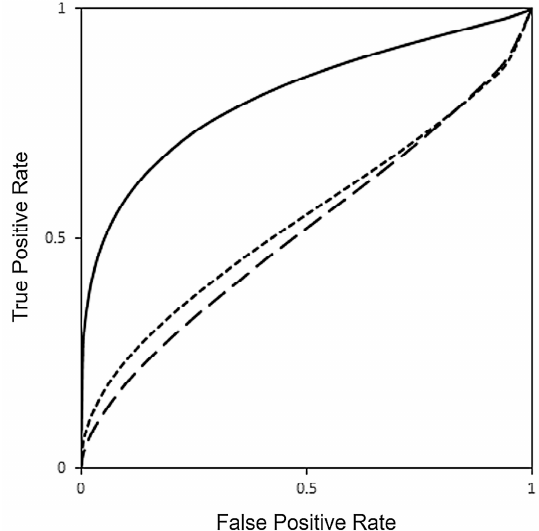
Figure 2. Receiver operating characteristic (ROC) curves for detection of clinically important dif- ference (CID) in motor dysfunction with VR (continuous line, AUC = 0.8418), [ 123 I]FP-CIT SPECT (long dashed line, AUC = 0.5357) and [ 123 I]FP-CIT SPECT with PD medications (short dashed line, AUC = 0.5397) obtained using a SVM machine learning classification model.